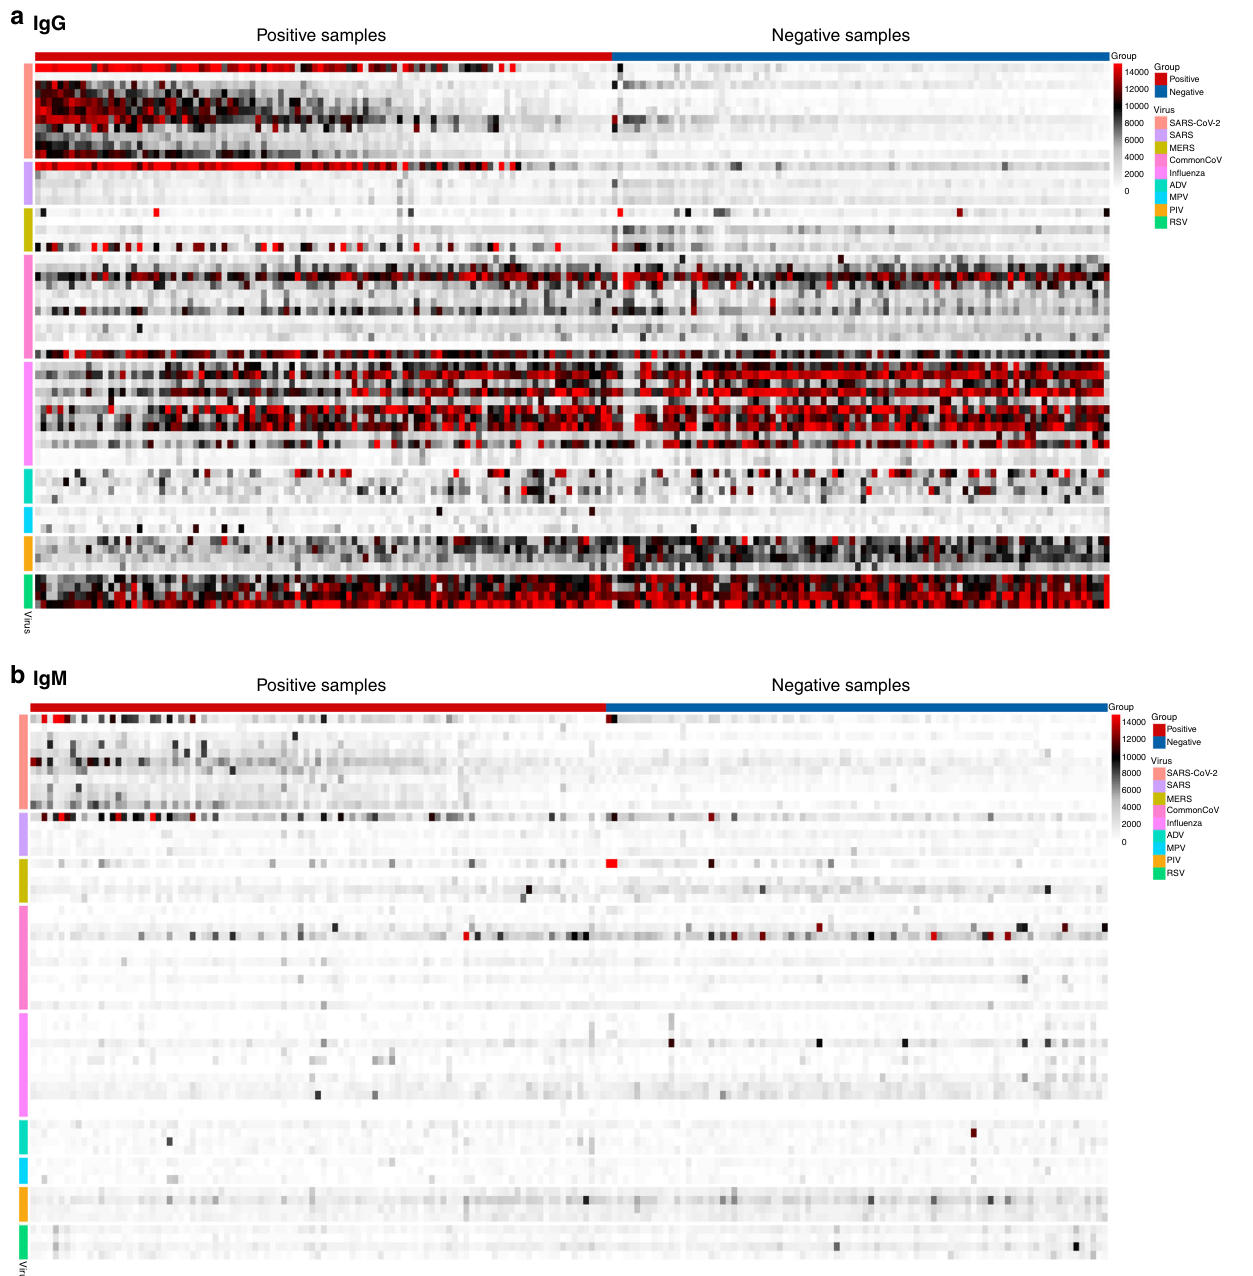
Fig. 1 Heatmap for coronavirus antigen microarray. The heatmap shows IgG (top) and IgM (bottom) reactivity measured as mean fl uorescence intensity across four replicates, against each antigen organized into rows color coded by virus, for blood specimens organized into columns classi fi ed as positive (convalescent from PCR-positive individuals) or negative (prior to pandemic from naive individuals). Reactivity is represented by color (white = low, black = mid, red = high). Source data are provided as a Source data fi